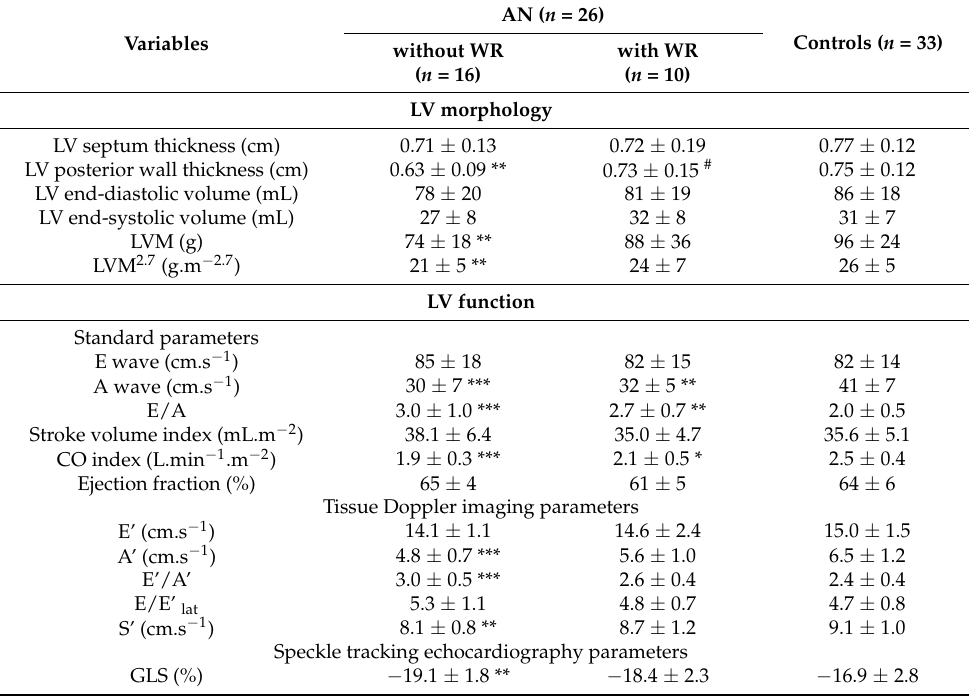
Table 2. Left ventricular morphology and function in AN patients without and with WR and controls.